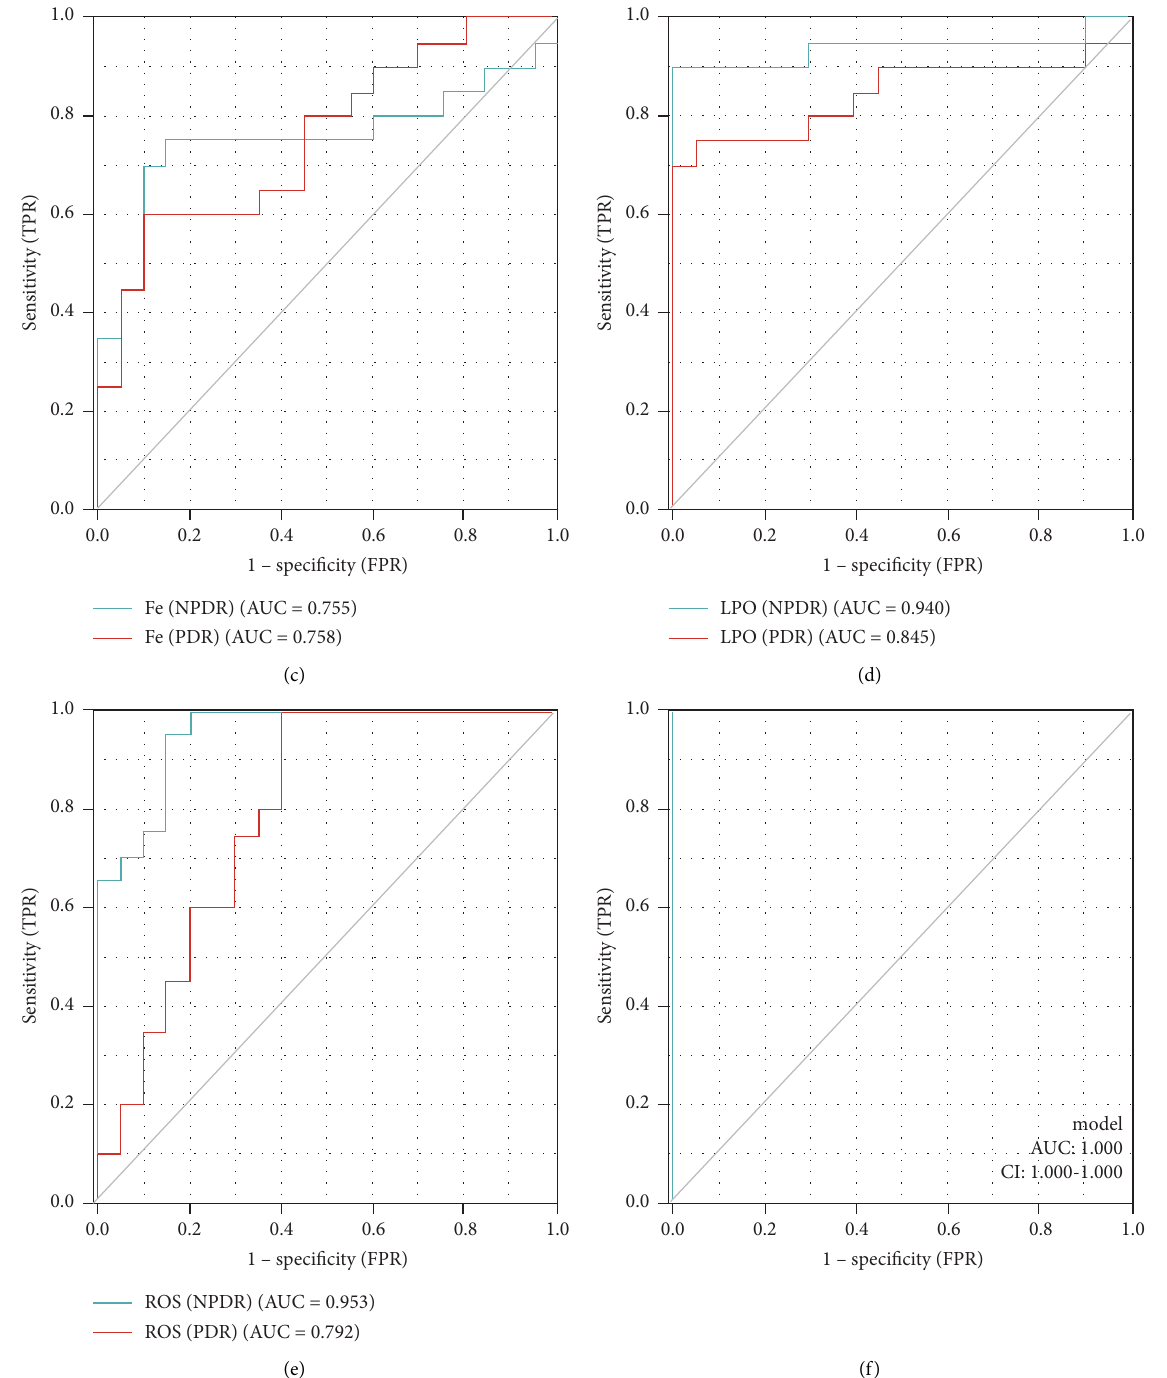
Figure 2: ROC curve for ferroptosis-related biomarkers in NPDR and PDR groups. (a) Diagnostic accuracy of GPX4 in NPDR and PDR; (b) diagnostic accuracy of GSH in NPDR and PDR; (c) diagnostic accuracy of LPO in NPDR and PDR; (d) diagnostic accuracy of Fe in NPDR and PDR; (e) diagnostic accuracy of ROS in NPDR and PDR; (f) diagnostic accuracy of all ferroptosis-related biomarkers in NPDR and